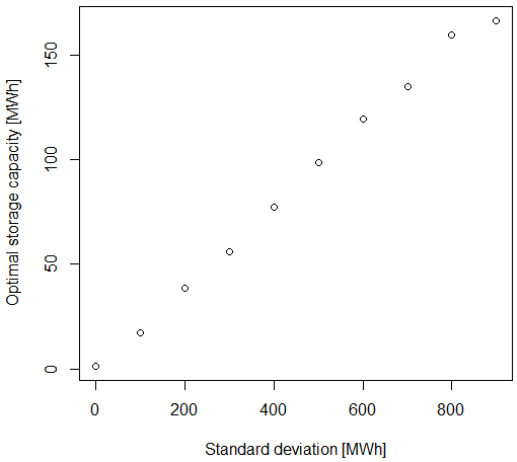
Figure 14. Optimal storage capacity according to the energy standard deviation.